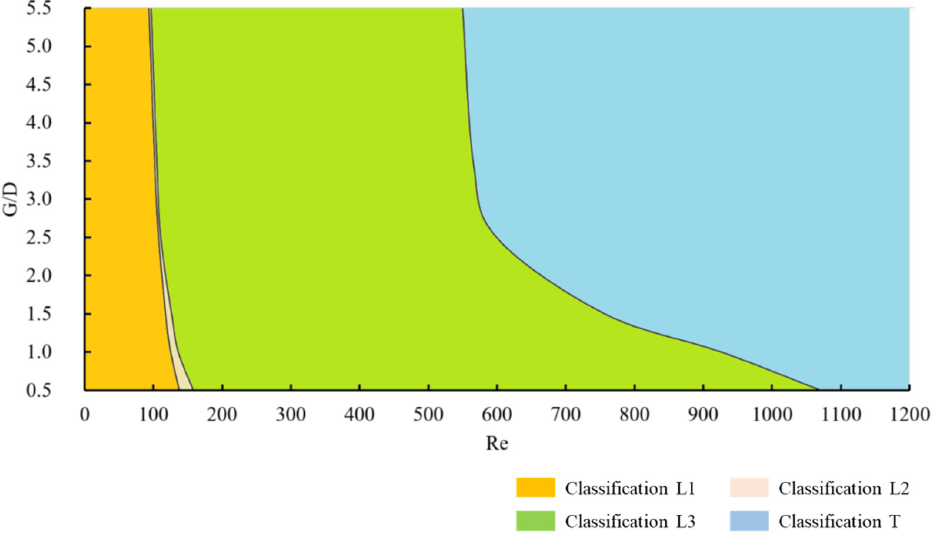
Figure 12. Flow pa tt ern classi fi cation map of the fl ow around a square cylinder under boundary Figure 12. Flow pattern classification map of the flow around a square cylinder under boundary constraint.